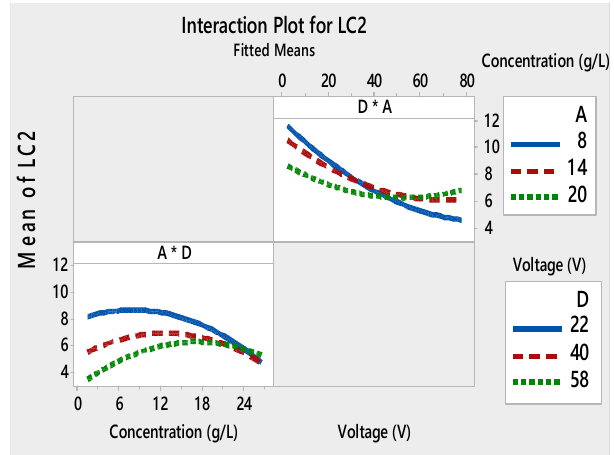
Figure 5. Interaction plots for L C2 ((*) refers to multiplication sign (×)).